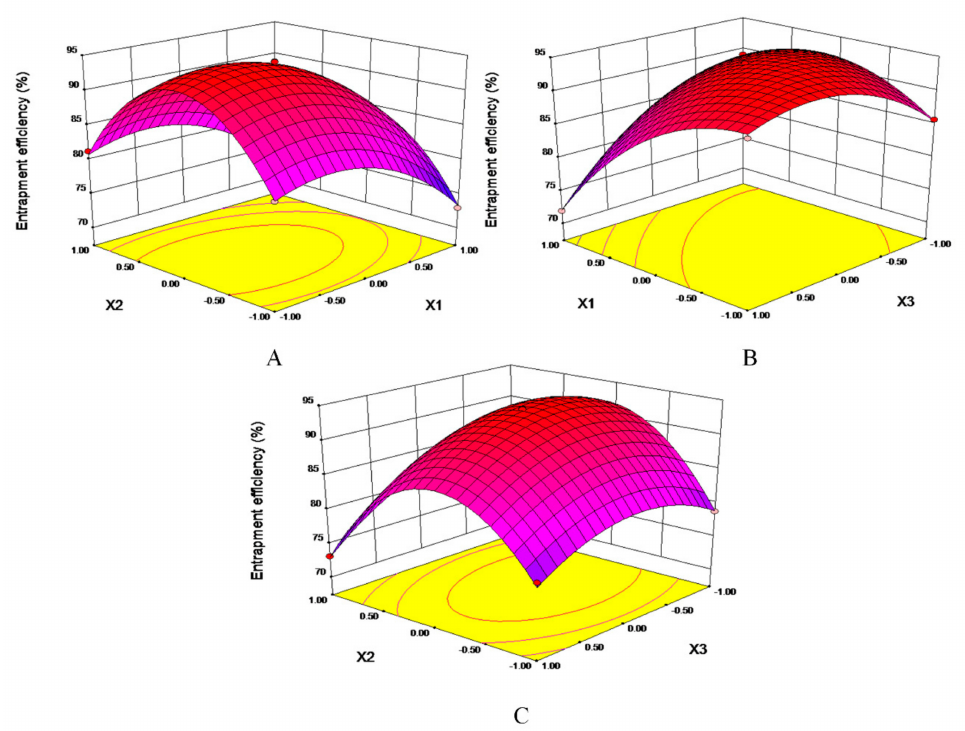
Figure 1. Response surface plots showing the interaction of factors. ( A ): EE% = f ( X1 , X2 ). ( B ): EE% = f ( X1 , X3 ). ( C ): EE% = f ( X2 , X3